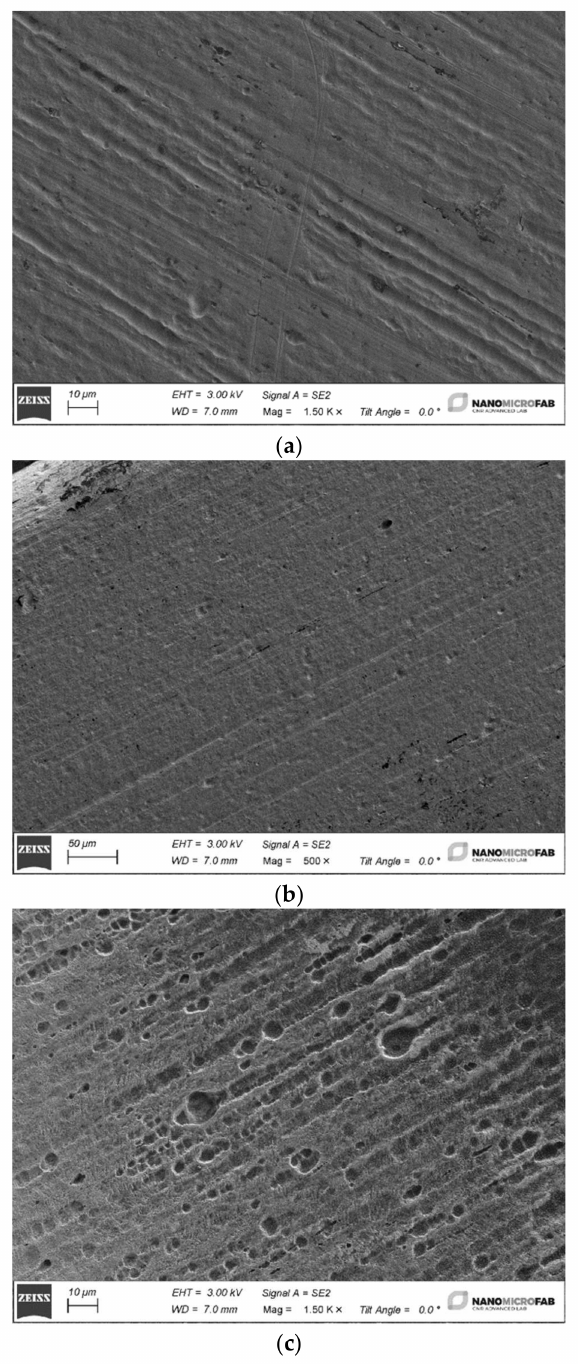
Figure 4. ( a ) An image of the Ni–Ti sample before the ageing test; ( b ) an image of a Ni–Ti sample at lower magnification after one week of aging in Miradent mirafluor ® dental gel; ( c ) the surface of the Ni–Ti sample after the ageing for one week in Elmex ® dental